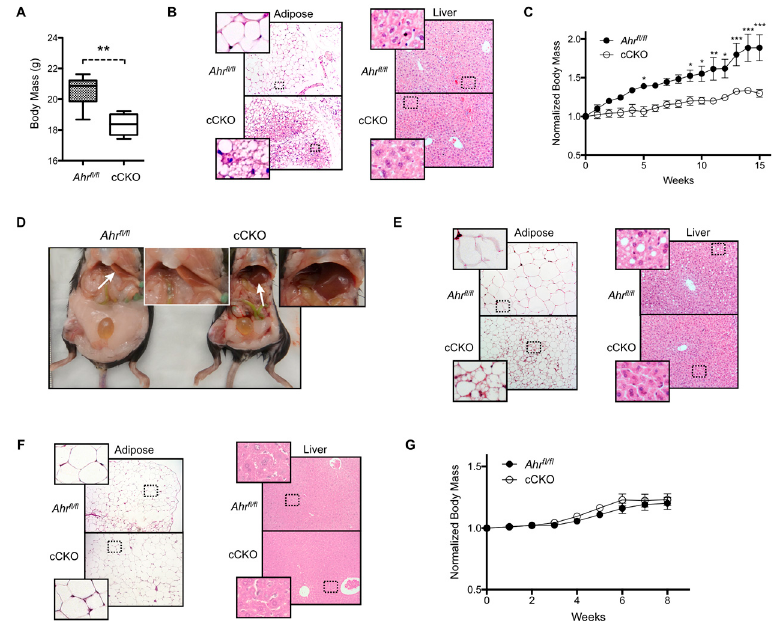
Figure 1. Constitutive loss of hepatocyte aryl hydrocarbon receptor (AHR) expression in female mice reduces weight gain and adiposity. ( A ) 10-week old female hepatocyte-targeted AHR conditional knockout mice ( Ahr fl/fl Alb-Cre , herein referred to as “cCKO”) exhibit significantly decreased body mass ( n = 6 per genotype). ( B ) Hematoxylin and eosin (H&E)-stained perigonadal white adipose tissue